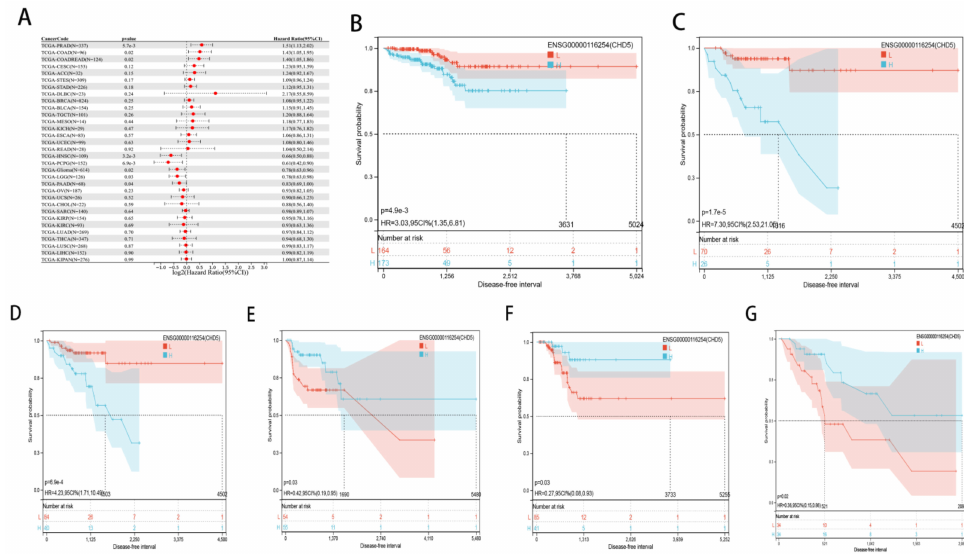
Figure A3. Correlation between CHD5 expression and progression-free interval (PFI). ( A ) Forest plots showing the association between CHD5 expression and PFI in 44 tumor types. Kaplan-Meier analyses of the association between CHD5 expression and PFI in ( B ) Glioma, ( C ) Pan-kidney cohort (KICH+KIRC+KIRP) (KIPAN), ( D ) Pancreatic adenocarcinoma (PAAD), ( E ) Kidney Chromophobe (KICH), ( F ) low grade glioma (LGG), ( G ) Pancreatic adenocarcinoma (PAAD).